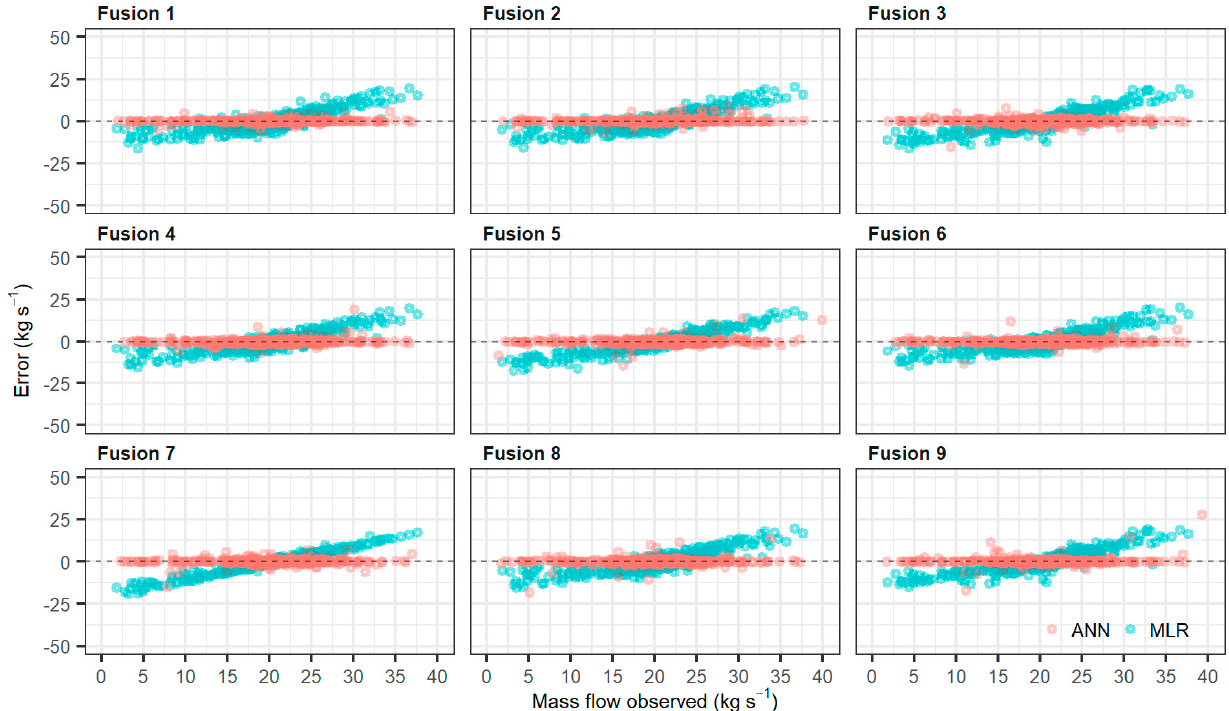
Figure 5. Scatter plot of the Multiple Linear Regression (MLR) and NARX Neural Network (ANN) models prediction error.